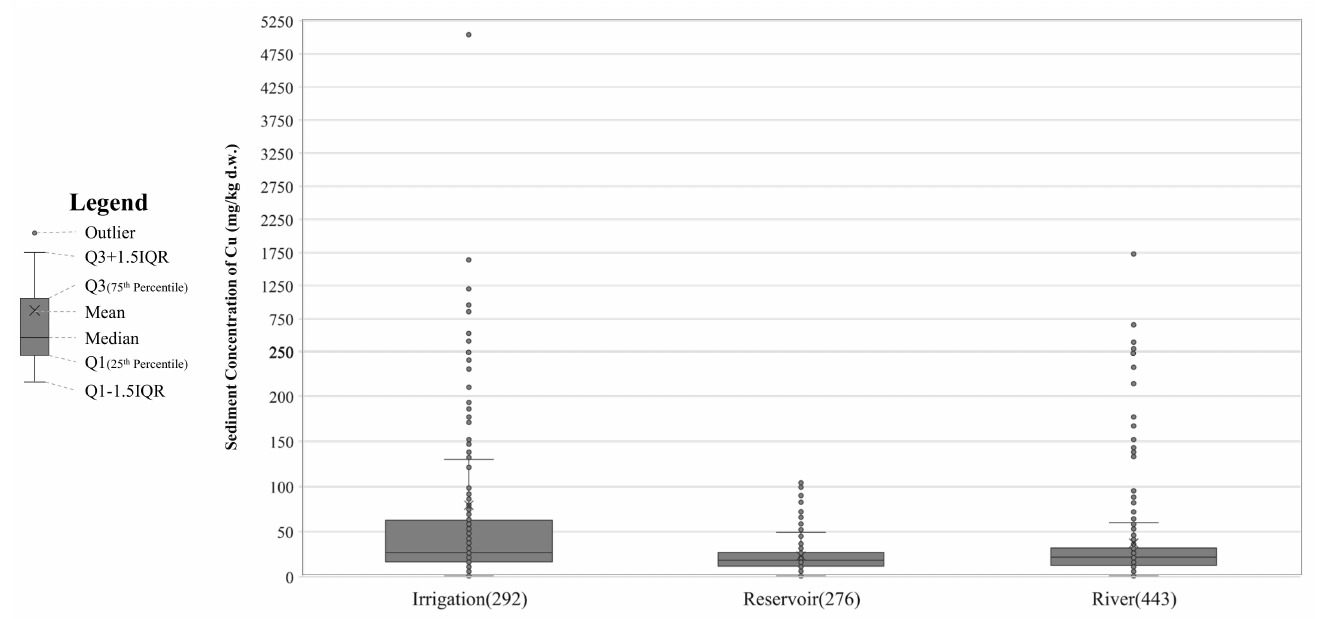
Figure 1. Box-and-whisker plot analysis of sediment quality in irrigation canals, rivers, and reservoirs based on Cu concentration. The number in the parentheses is the number of sampling